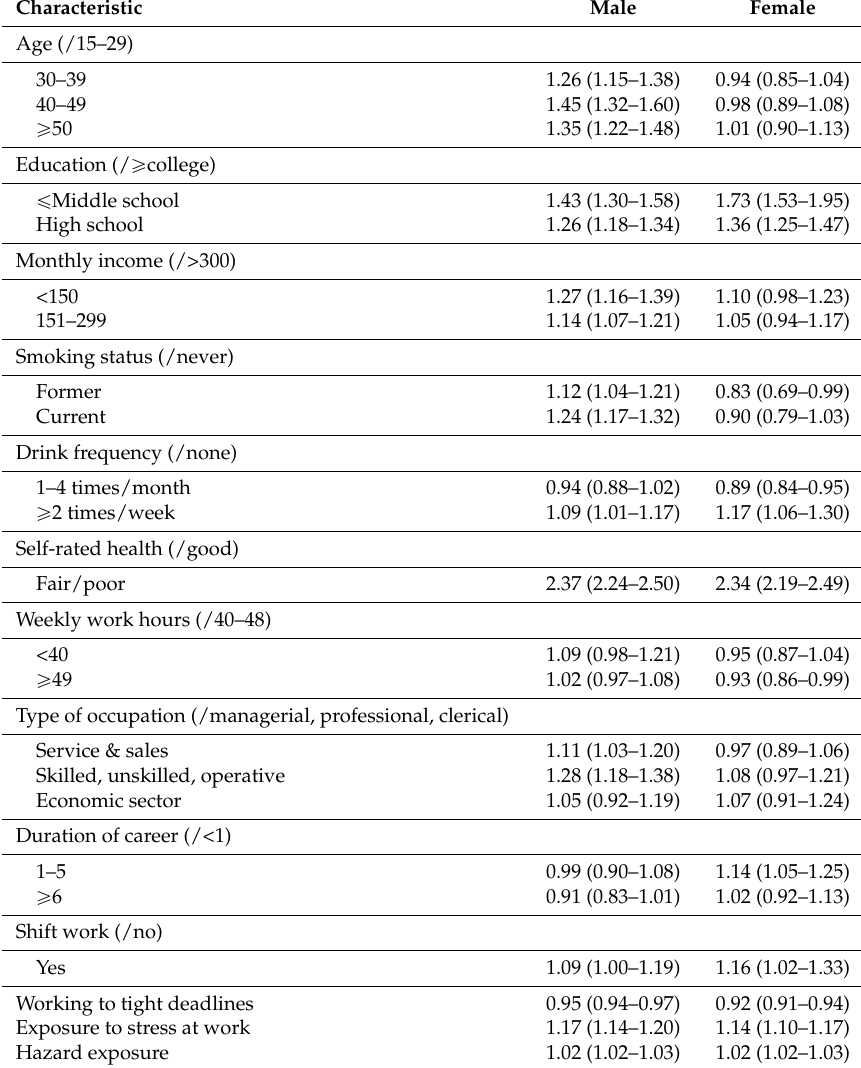
Table 4. Odds ratios (95% CI) for depressive symptoms according to